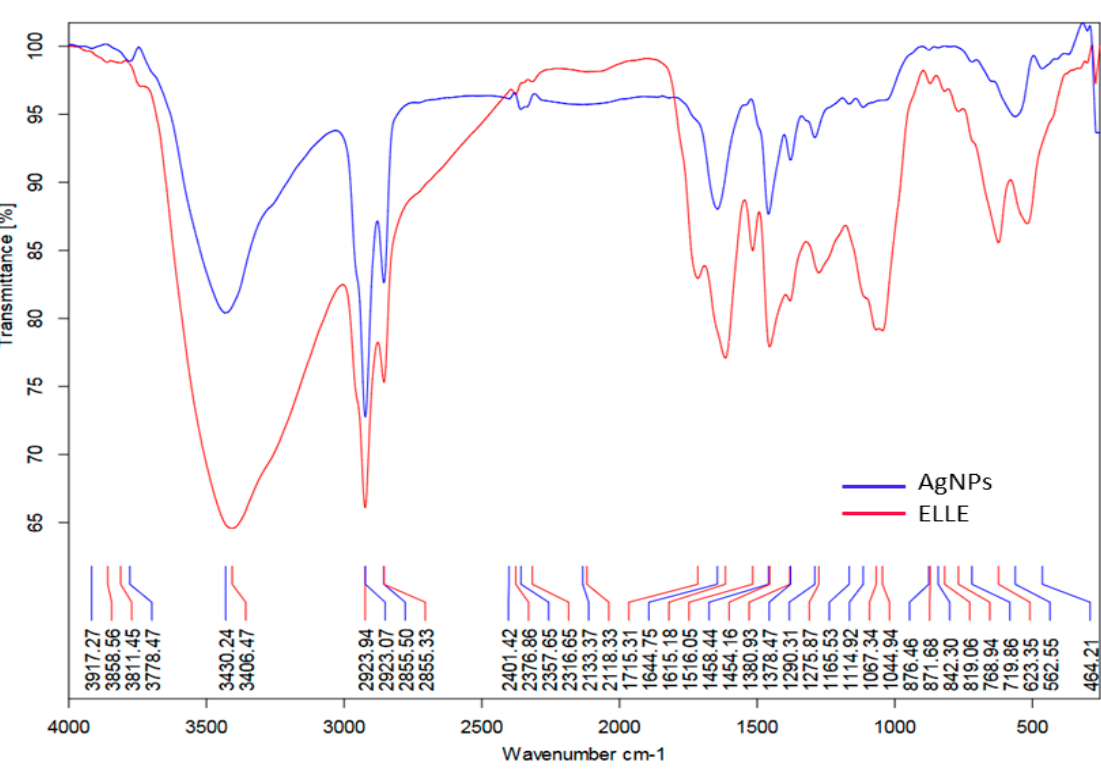
Figure 3. FTIR spectrum of AgNPs and ELLE.